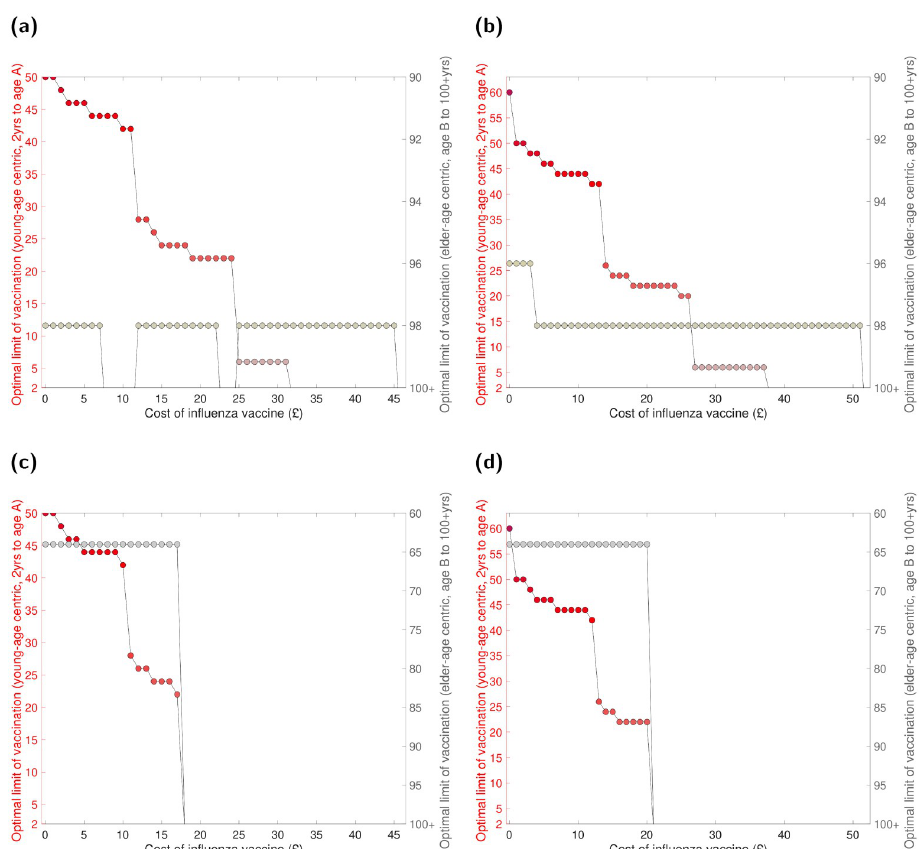
vaccine values) are indicated by the filled red circles and grey circles, respectively. Columns correspond to optimal age coverage assuming: (a,c) a £20,000 cost-effectiveness threshold per QALY, successfully attained by the most likely